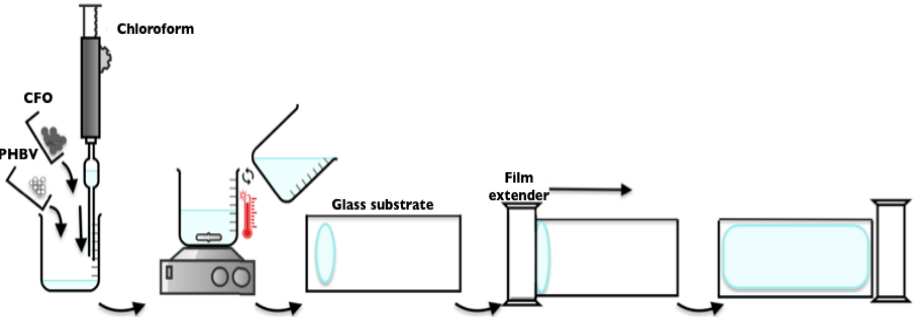
Figure 9. Schematic representation of the processing of the PHBV films by solvent casting.